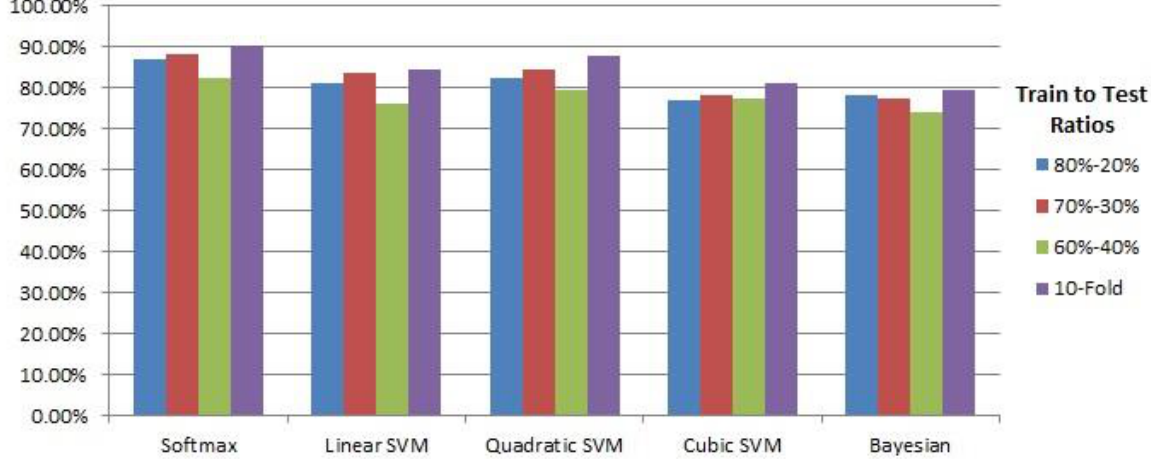
Figure 7. Accuracy results using contrast - enhanced images for various train - to - test ratios.